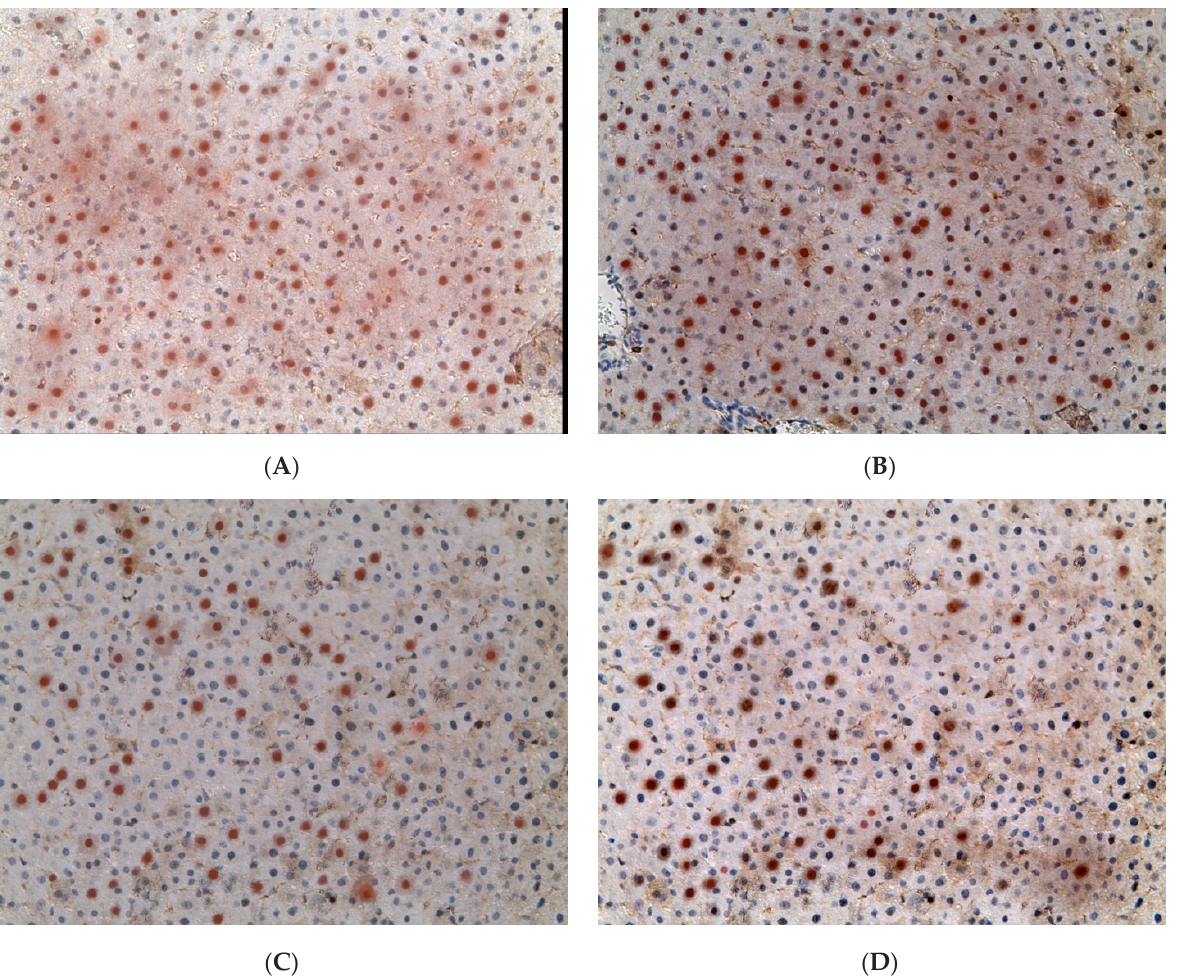
Figure 8. Expression of BMAL1 in liver of rats. ( A )—Control; ( B )—EtOH; ( C )—CL; ( D )—EtOH+CL. ×200.